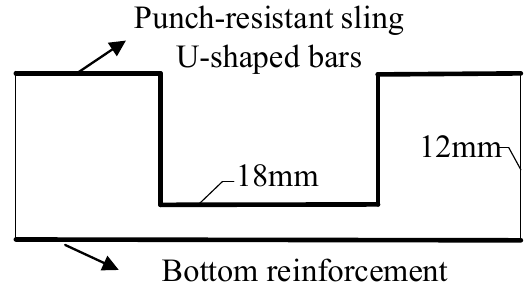
welding of the steel plate with the longitudinal reinforcement of the pier.